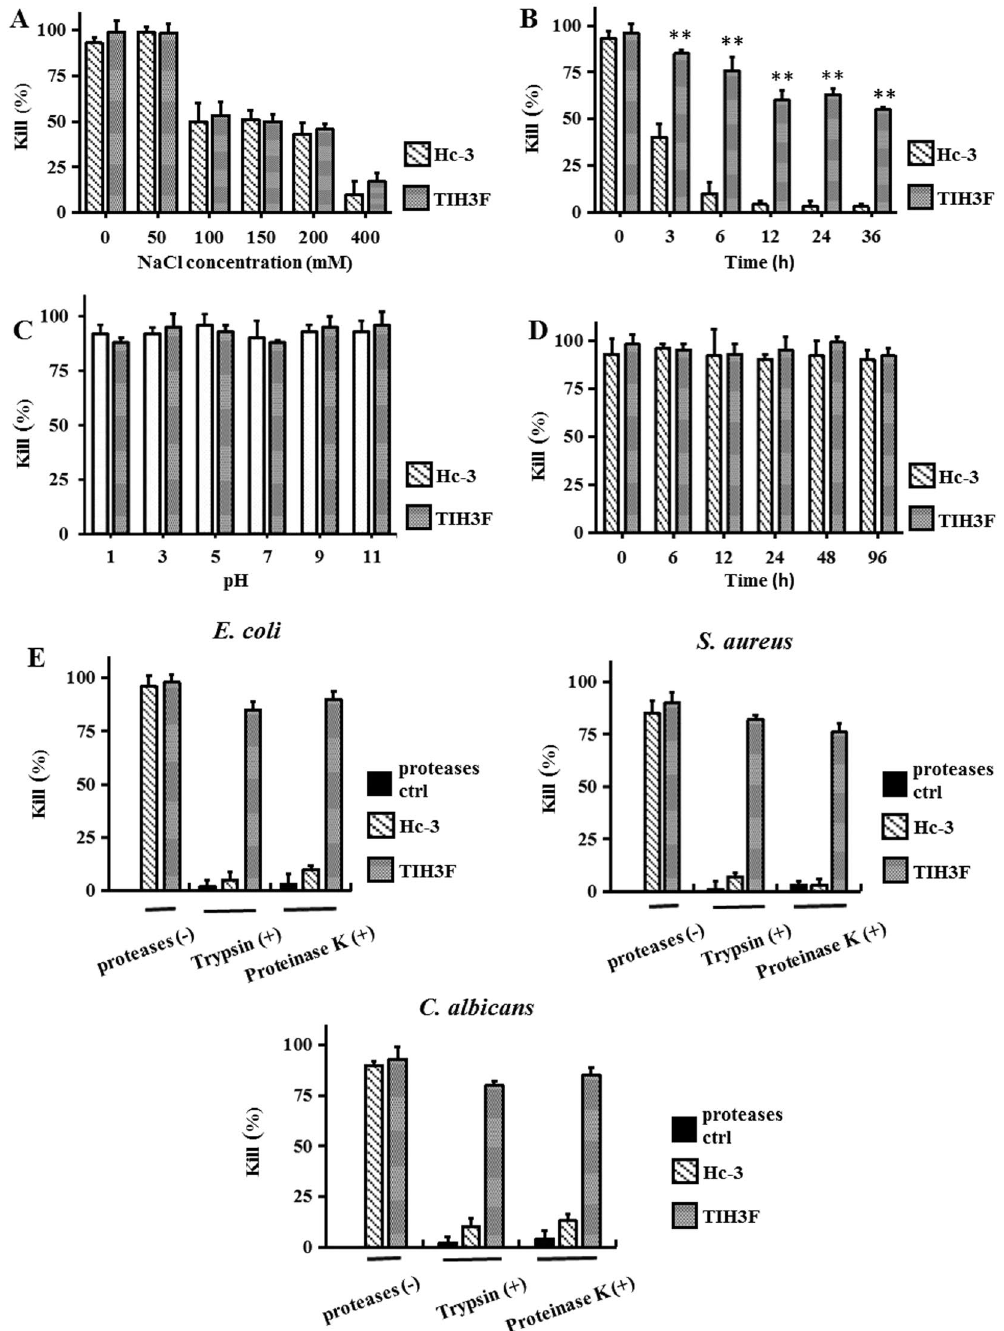
Figure 3. ( A ) Effects of various concentrations of NaCl on the antibacterial activity of Hc-3 and TIH3F against E. coli . ( B ) Stability of Hc-3 and TIH3F in human serum (20%). ( C ) Effects of pH value on the antibacterial activity Hc-3 and TIH3F against E. coli . ( D ) Thermal stability of Hc-3 and TIH3F at normal human body temperature of 37 °C. ( E ) Antimicrobial activities of Hc-3 and TIH3F under the influence of proteases (trypsin and proteinase K) against E. coli , S. aureus and C. albicans . ( F ) The degradation rates of Hc-3 and TIH3F after incubation with proteases (trypsin and proteinase K). Three separate experiments were performed to calculate the mean ± SD ( * P < 0.05; ** P < 0.01; by unpaired t